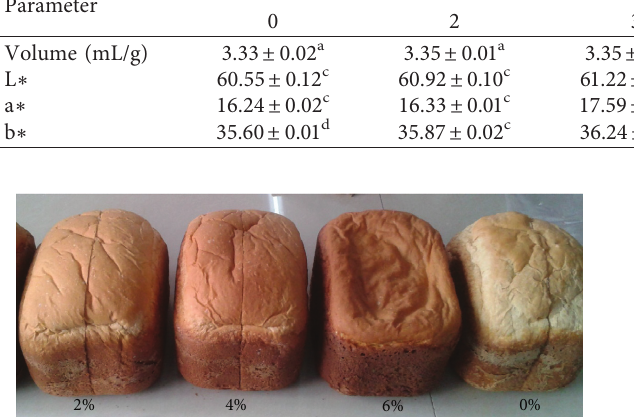
Figure 1: The effect of different addition levels of fermented wheat germ on the bread color (2%, 4%, and 6% wheat flour was replaced by fermented wheat germ flour).